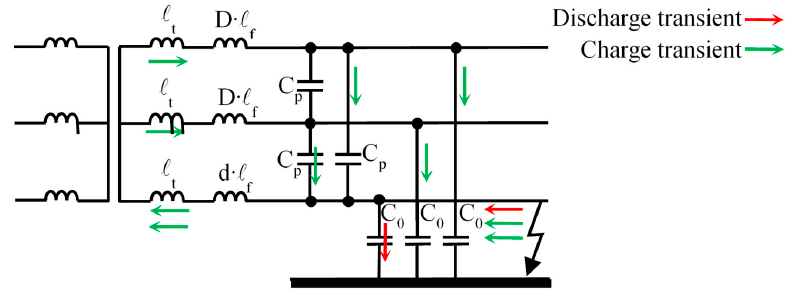
Figure 1. Charge and discharge transient circuits for a single line OHL for a PtG fault.